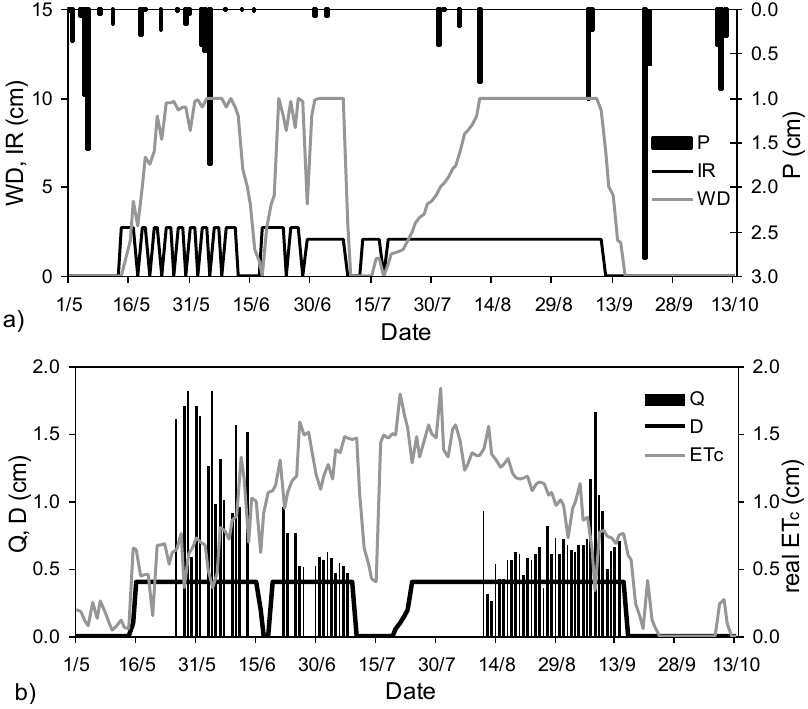
Figure 1. ( a ) Daily variation of ponding depth—WD, irrigation water amount—IR, and precipitation—P; ( b ) daily variation of surface runoff—Q, drainage—D, and actual crop evapotranspiration—ET c as computed by the modified GLEAMS-PADDY model